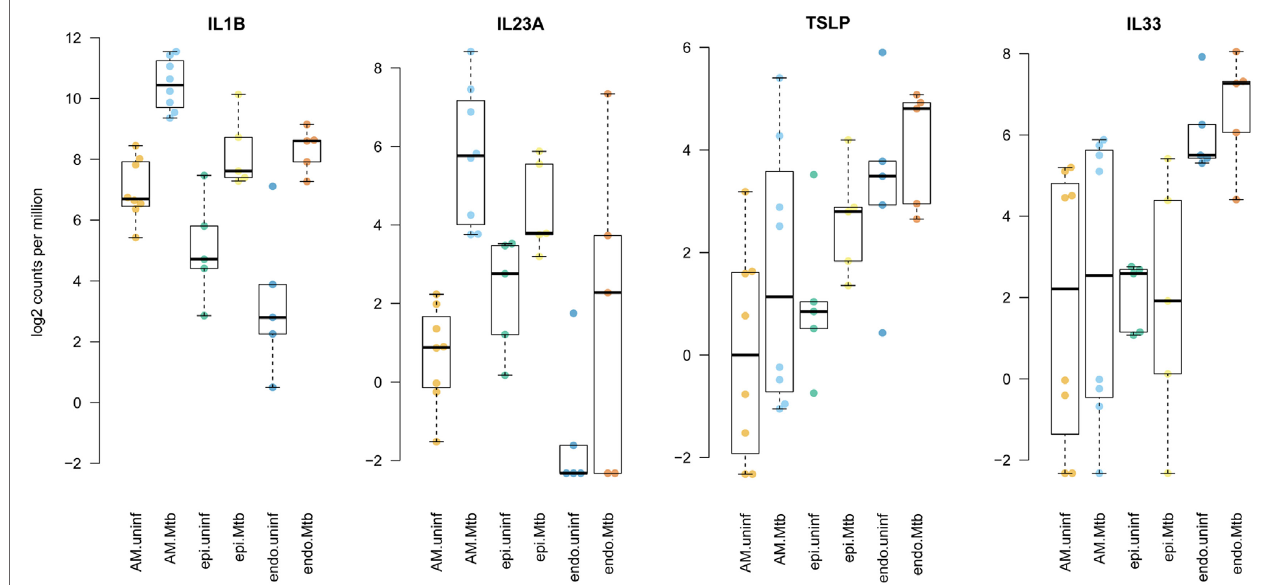
FigUre 4 | Enhanced expression of innate lymphoid cell stimulating cytokines by distinct tissue-resident cells upon stimulation with Mycobacterium tuberculosi s (Mtb). Plotted are log2 read counts per million sequenced reads from isolated cells for each donor tissue sample. Boxplots show median plus first and third quartile; whiskers extend to the most outer data point within 1.5 times the interquartile